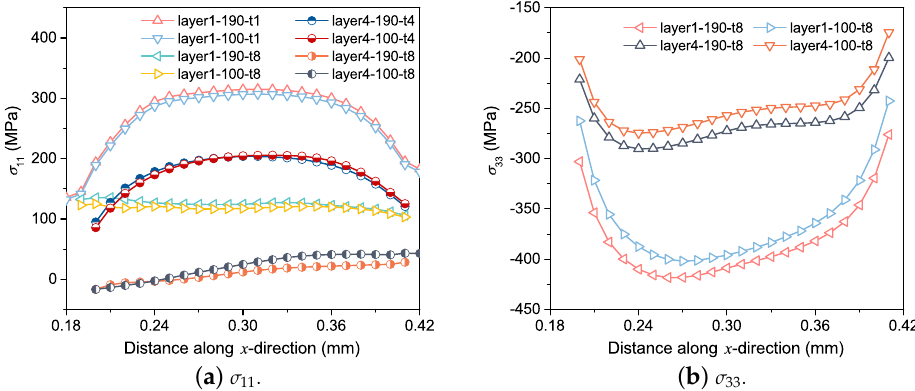
Figure 14. Comparison of stress distribution along the x direction at the center of the 4th and 8th layers under different laser